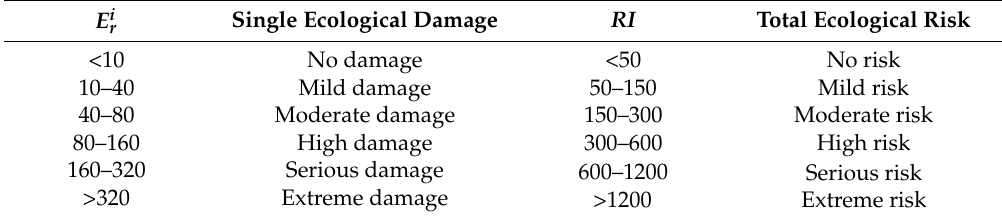
Table 7. Improved classification criteria of the potential ecological risk index.